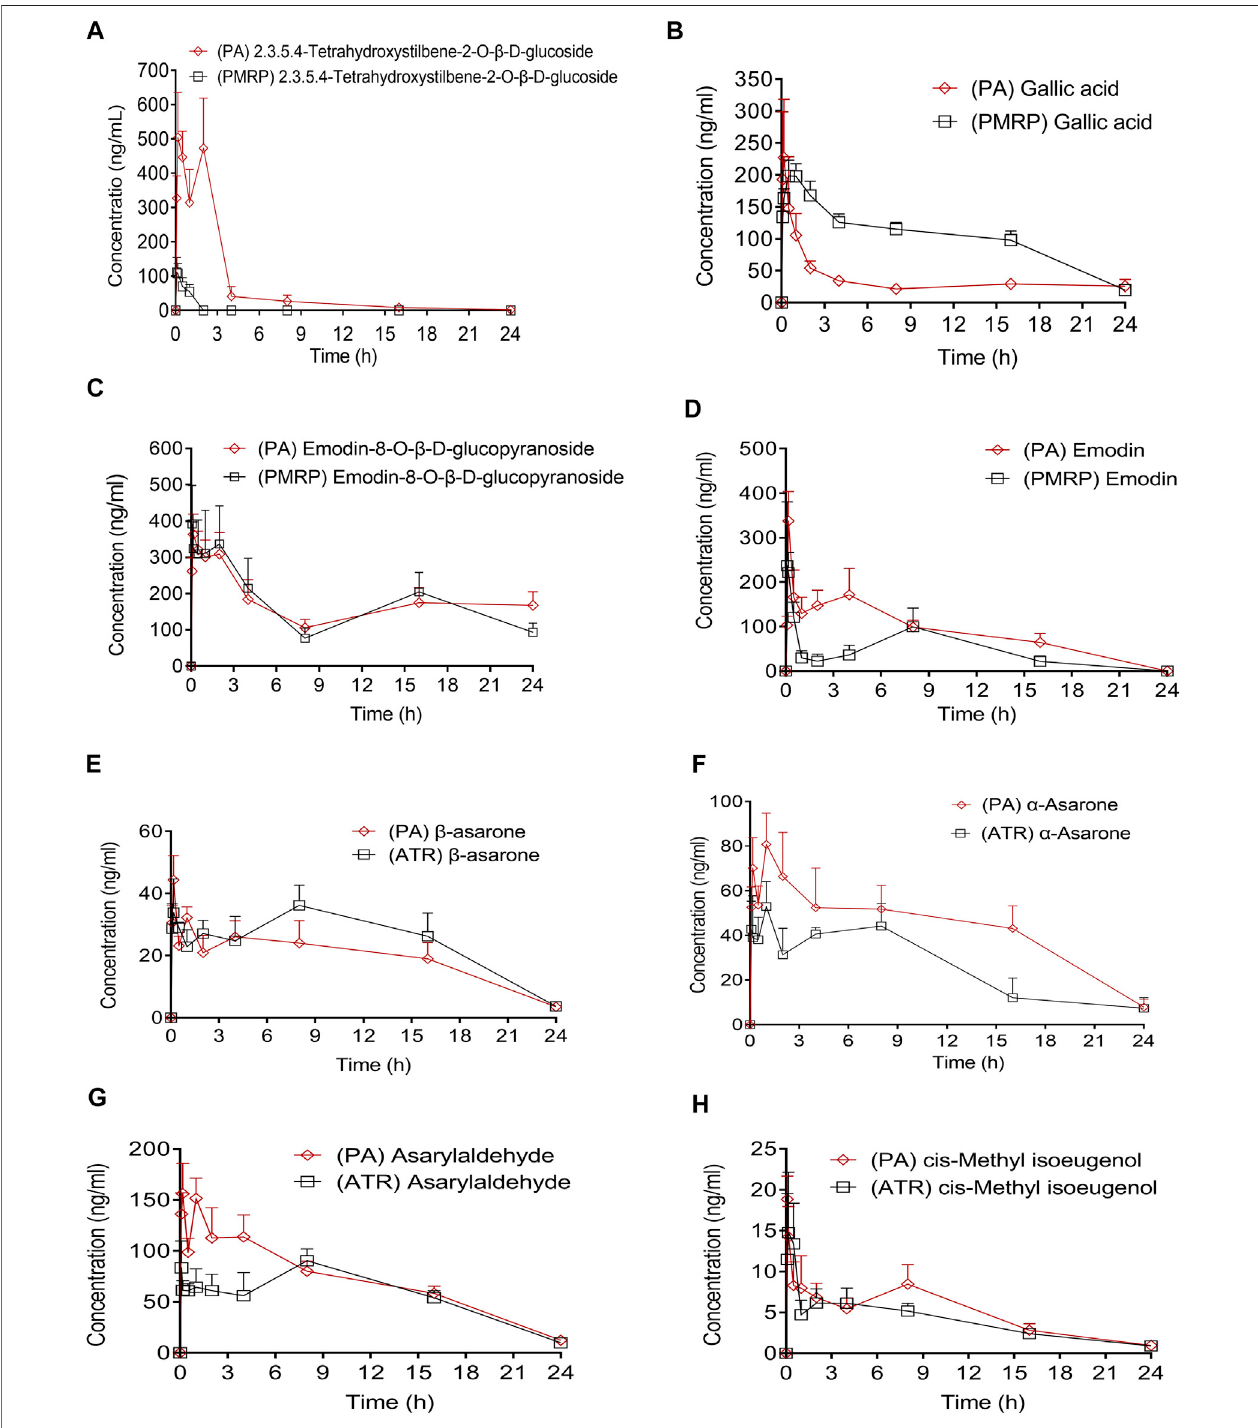
FIGURE 3 | Plasma concentration – time curves of eight compounds in rats following administration of PA, PMRP, and ATR. Data represent mean ± S.D. ( n (cid:1) 6).